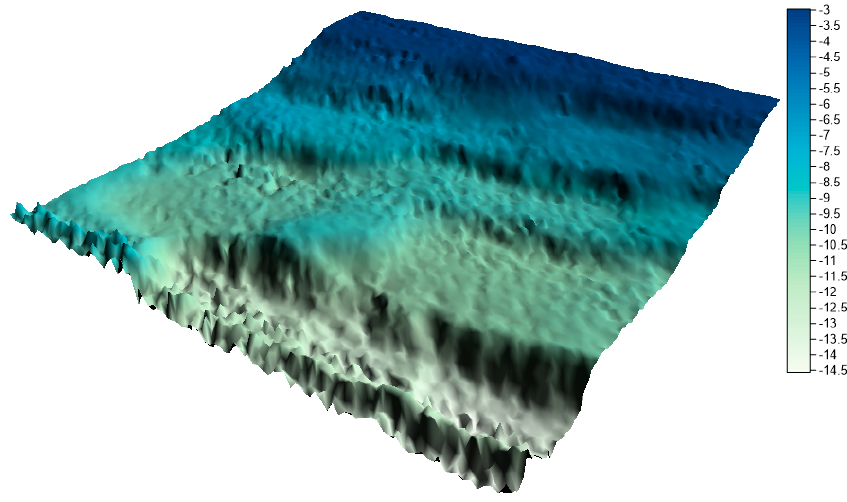
Figure 10. Reference surface for the LNG port area.